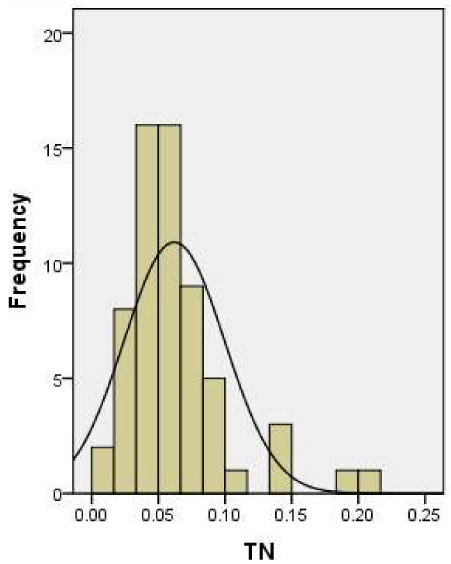
Figure 3. Histogram of soil TN content in sample